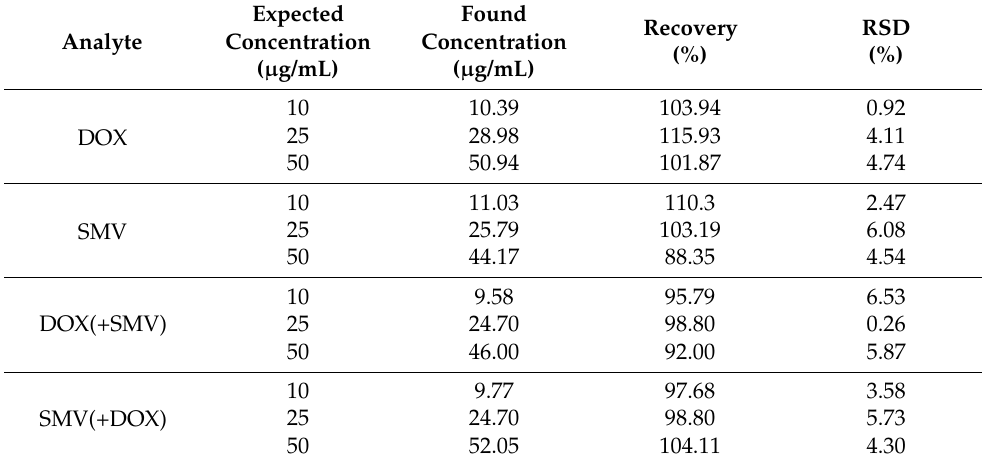
Table 3. Recoveries obtained for mono-component solutions of DOX and SMV and for solutions containing equal concentration of the two drugs prepared from pharmaceutical forms (10, 25, and 50 µ g/mL; in BRB pH 5 + 25%